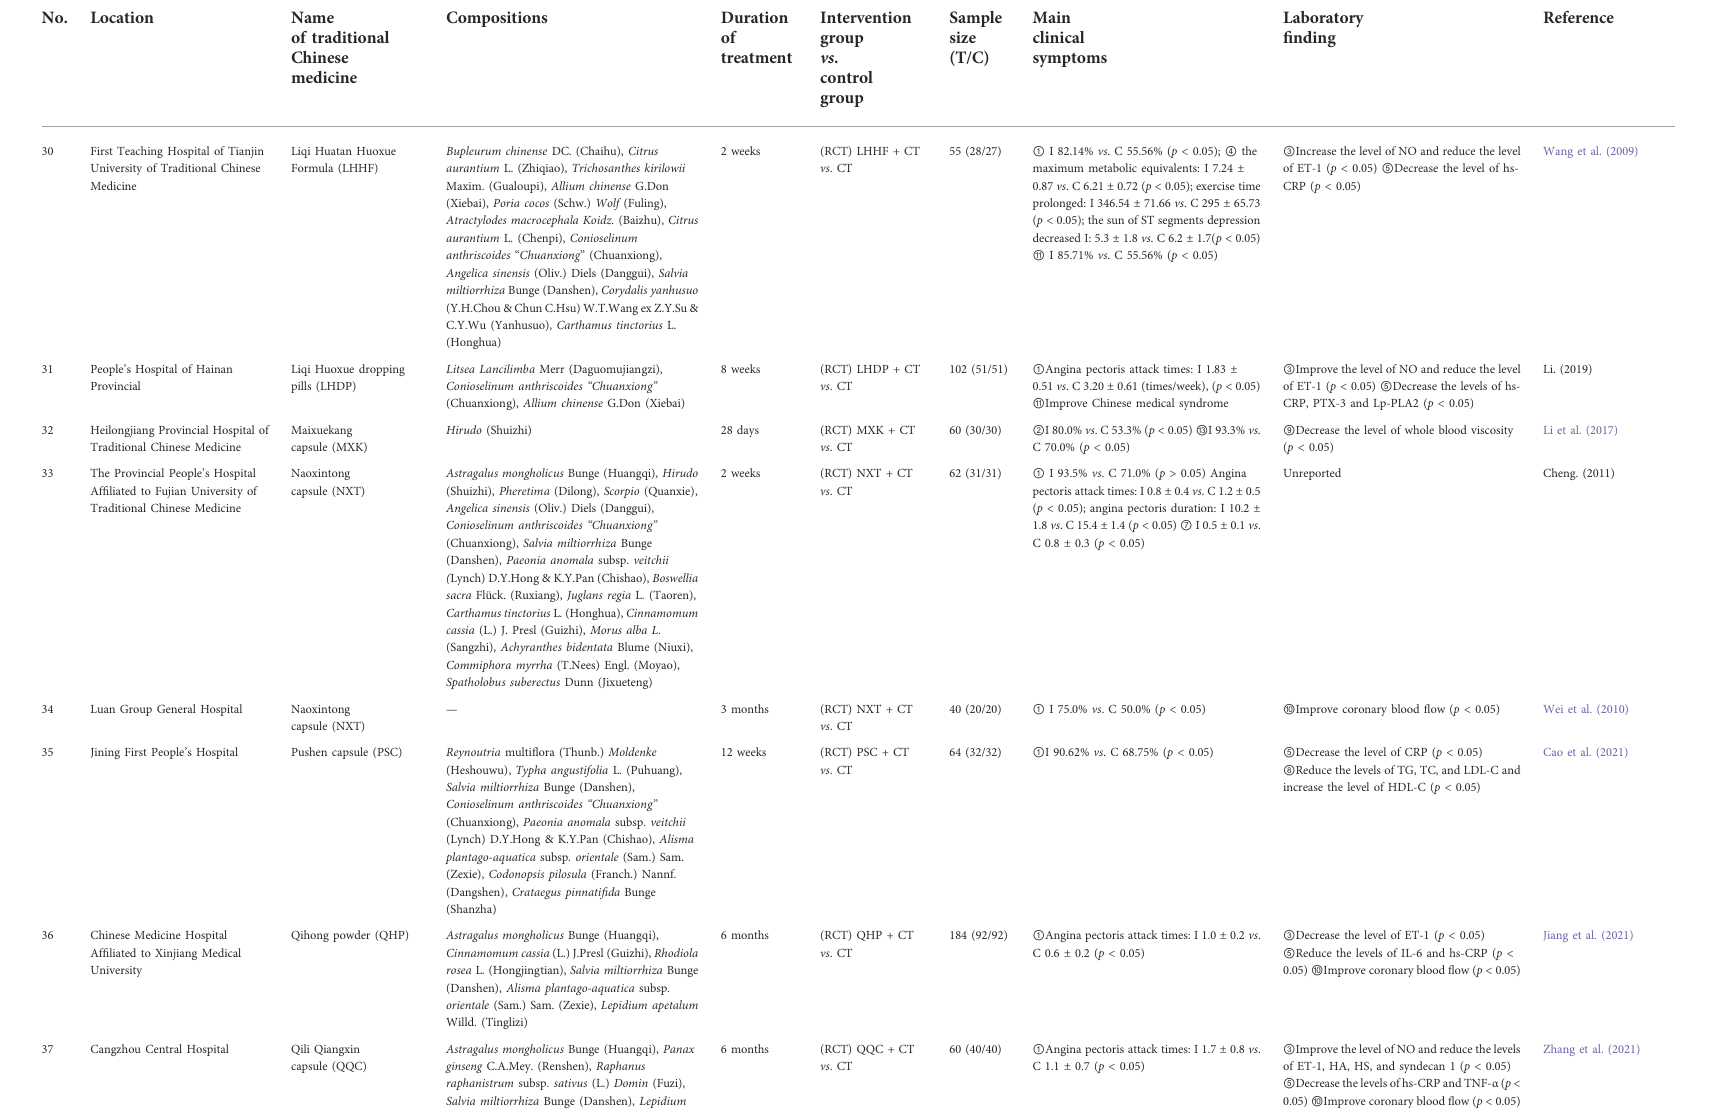
TABLE 1 ( Continued ) Clinical evidence of TCM for